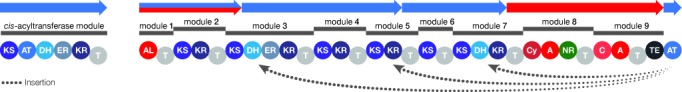
A recursive algorithm enables the identification of trans-acyltransferase modules split across two open reading frames in PRISM. Canonical cis-acyltransferase type I polyketide modules contain integrated acyltransferase domain for each module (left). In a hypothetical trans-acyltransferase polyketide cluster (right), modules lack integrated acyltransferase domains and may be split across open reading frames. A similar insertion process occurs when trans-acting adenylation domains are identified.